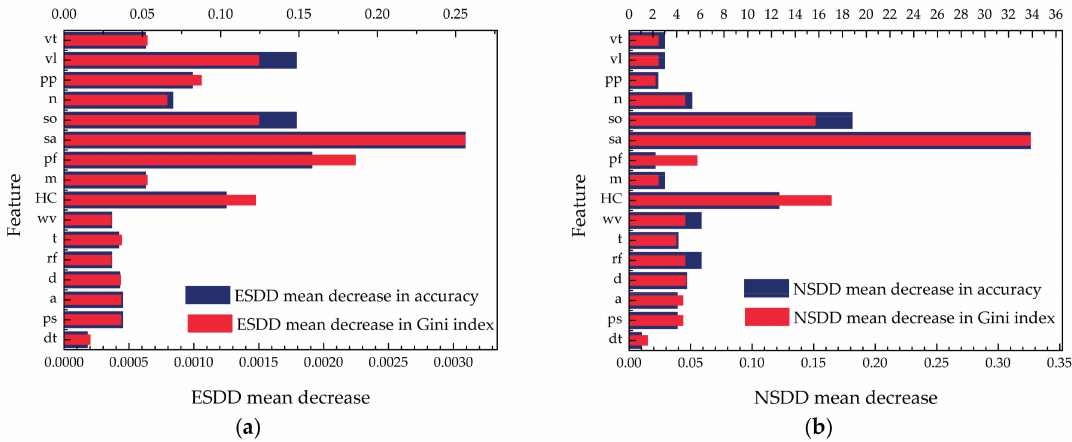
Figure 4. Importance analysis of influencing factors. ( a ) The results of ESDD; ( b ) The results of